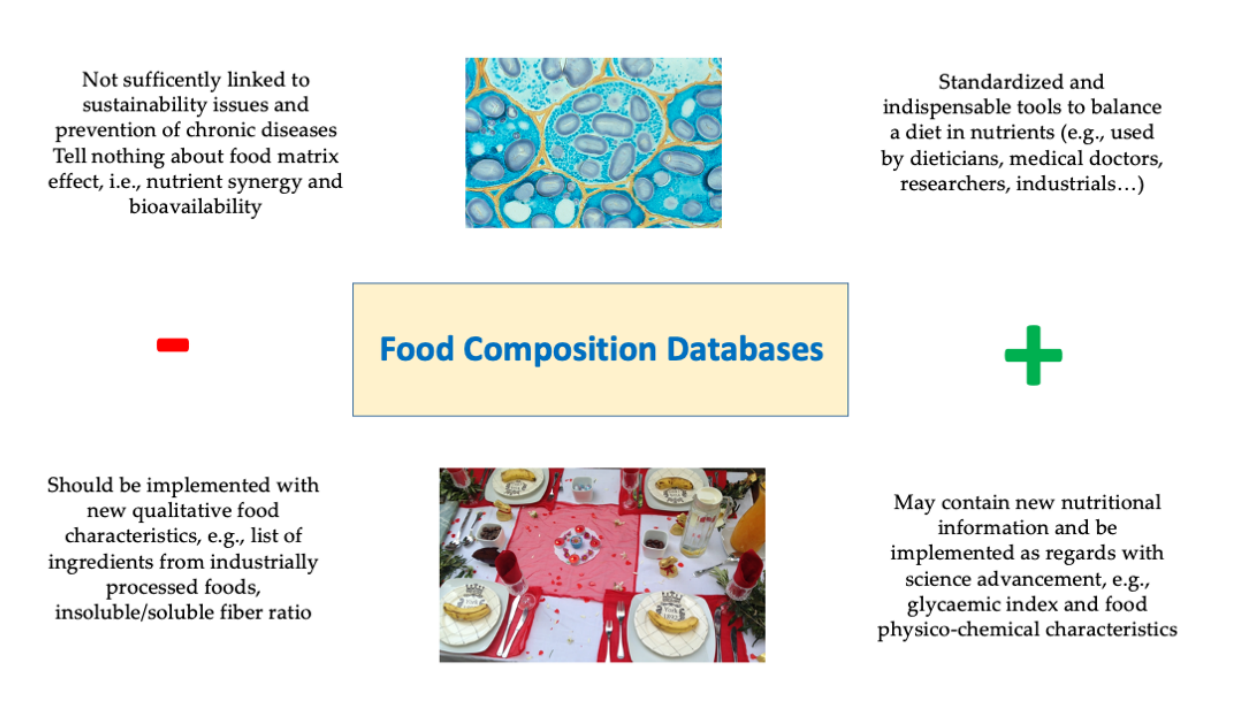
Figure 3. Main features, common uses, identified gaps, and expected trends of food composition databases (original figure by Anthony Fardet; photos: INRAE for bean food matrix under optical microscopy and Am é lia Delgado for the meal